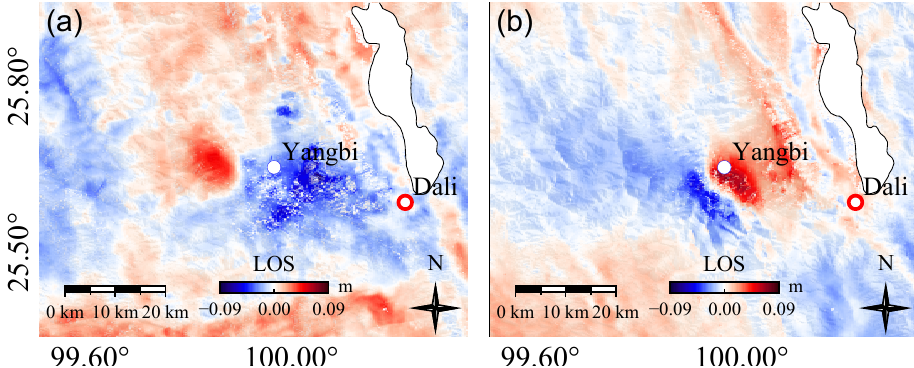
Figure 3. Surface deformation fields ( a ) for the ASC, and ( b ) for the DSC.